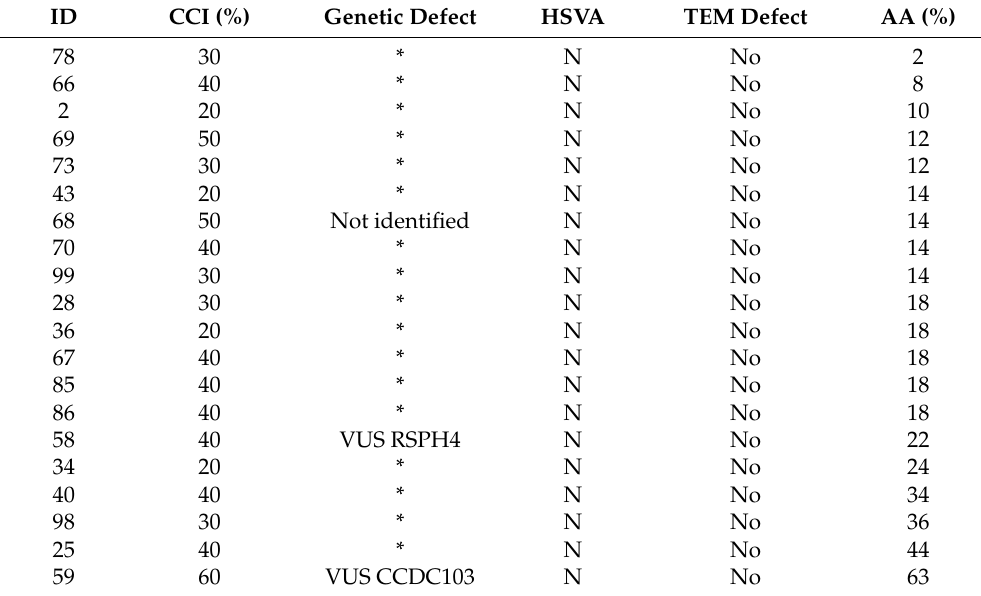
Table 3. Summary of diagnostic tests and CCI of control group according to axonemal asymmetry.